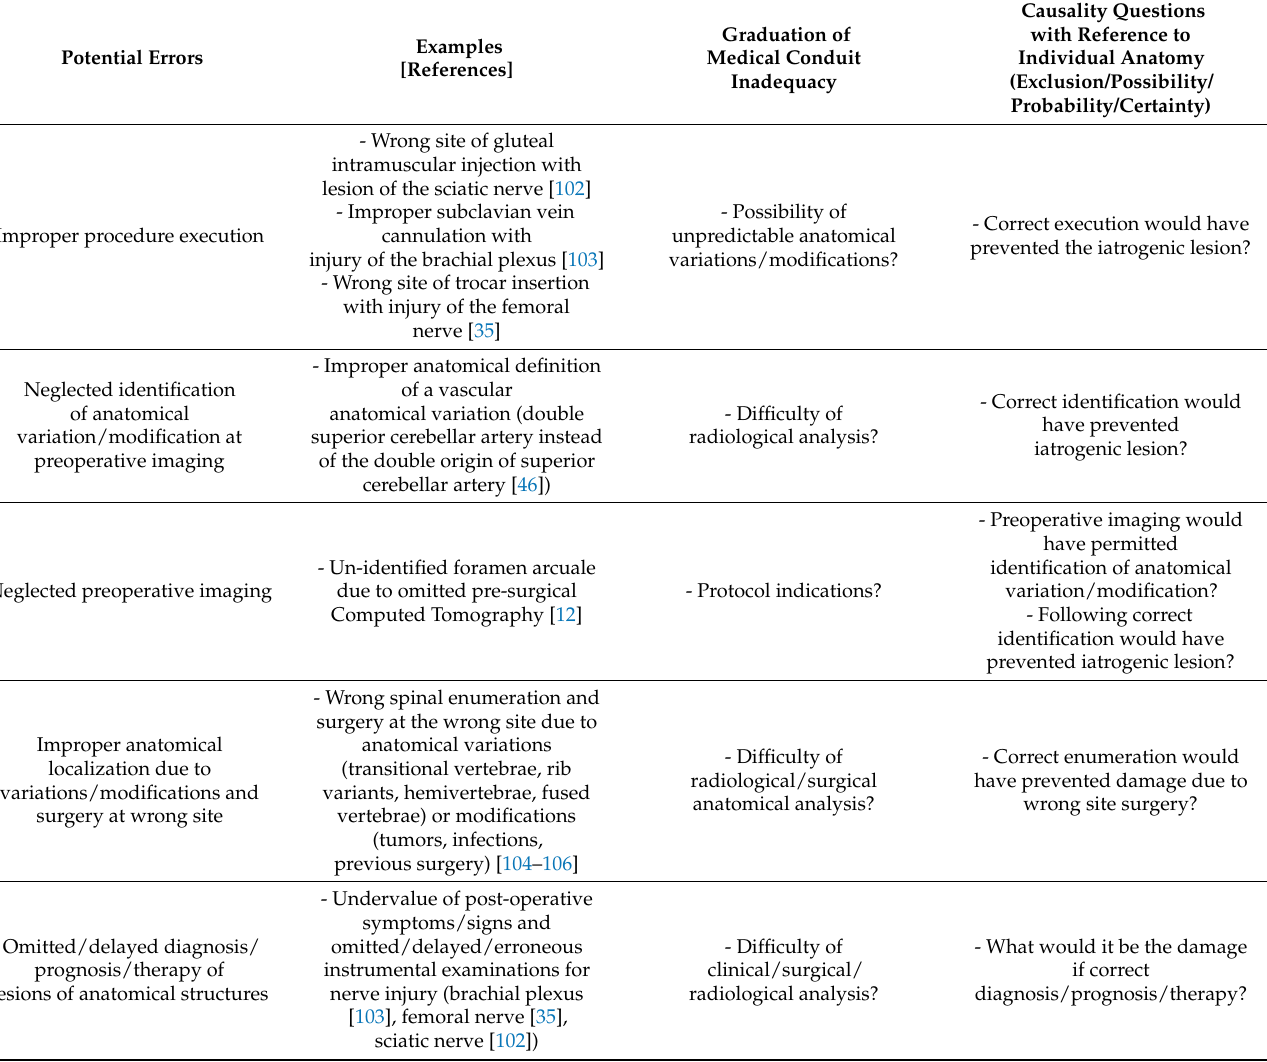
Table 1. Iatrogenic lesions of normal/variant/modified anatomical structures: potential anatomy- related errors and considerations in terms of medical conduit and